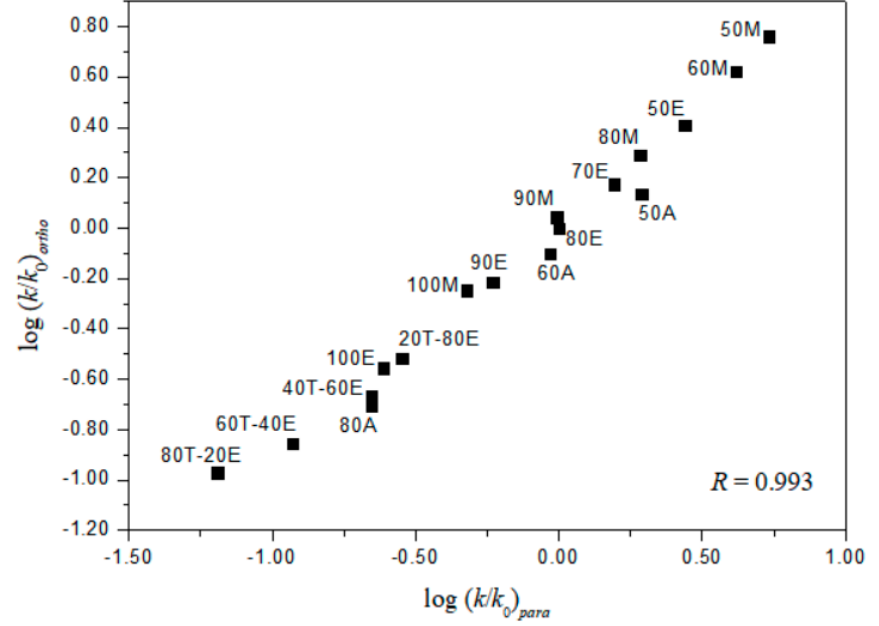
Figure 3. The plot of log( k / k o ) ortho vs. log( k / k o ) para for the solvolyses of 1 and 3 in various organic solvents at 45 °C.